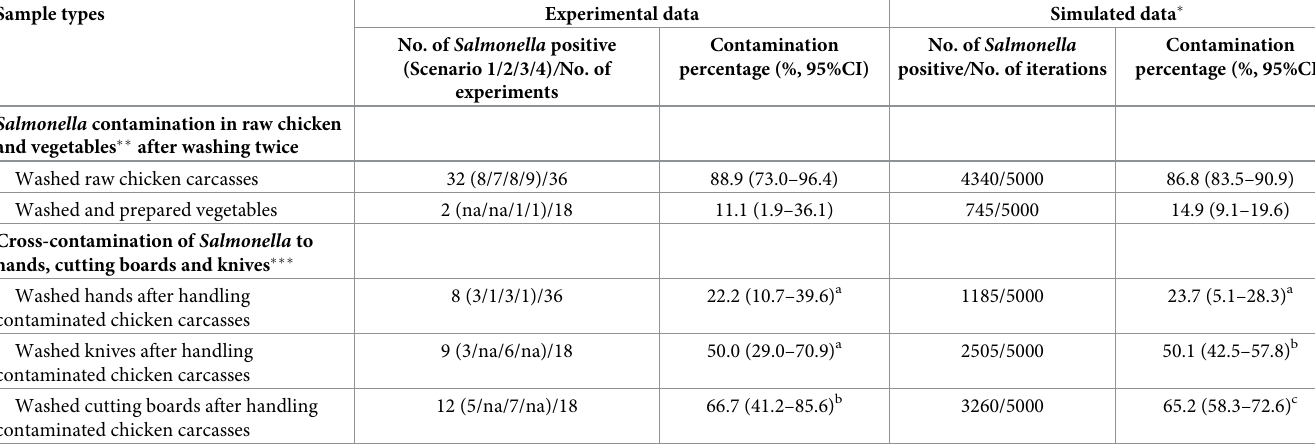
Table 3. Salmonella contamination from the raw chicken after washing twice and vegetables, hands, knives and cutting boards during chicken salad preparation. Sample types